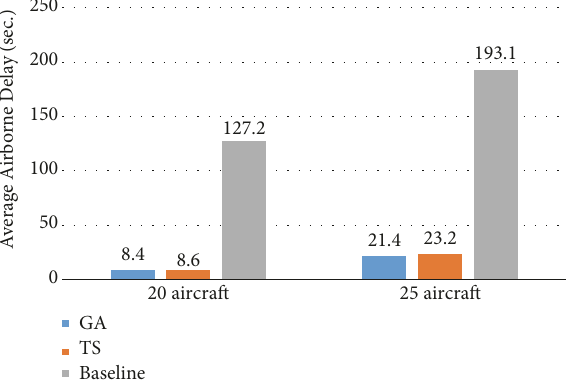
Figure 10: The average airborne delay for two different aircraft flow